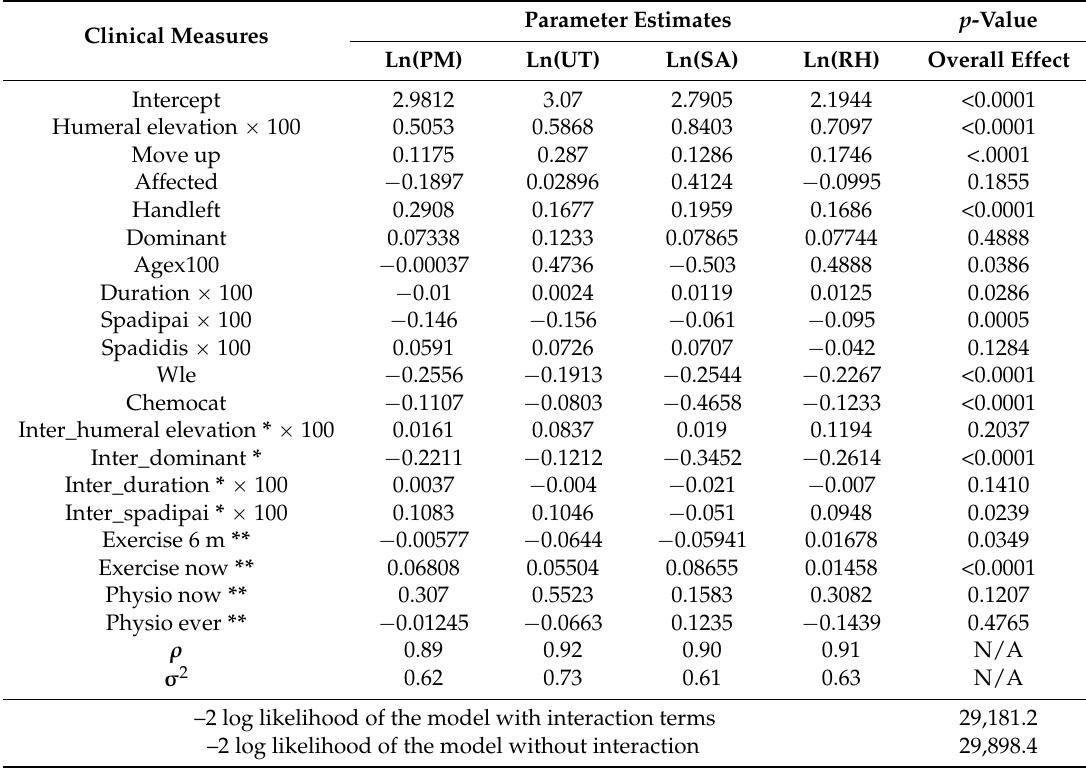
Table 1. Results of the analysis using a multivariate normal distribution with autoregressive of order one (AR(1)) structure for Σ k